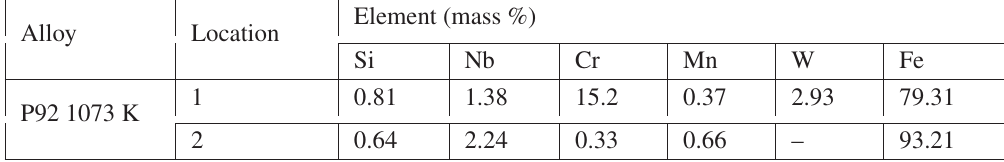
Table 3. EDAX analysis of various points on the oxide scale P92 alloys at 1073 K.